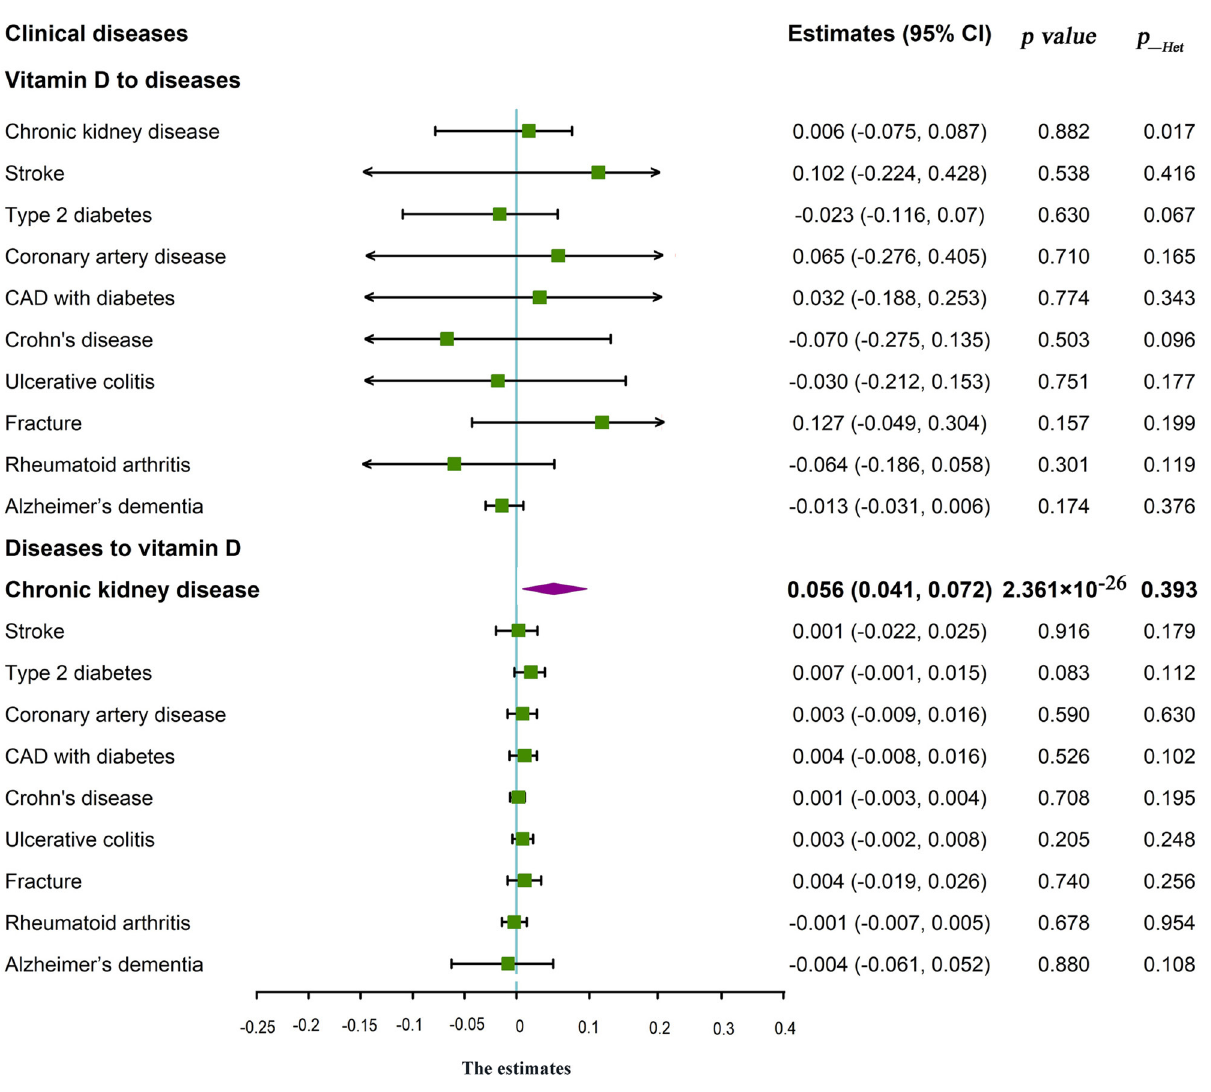
statistic effects of genetic instruments in Mendelian randomization analyses did not be influenced by